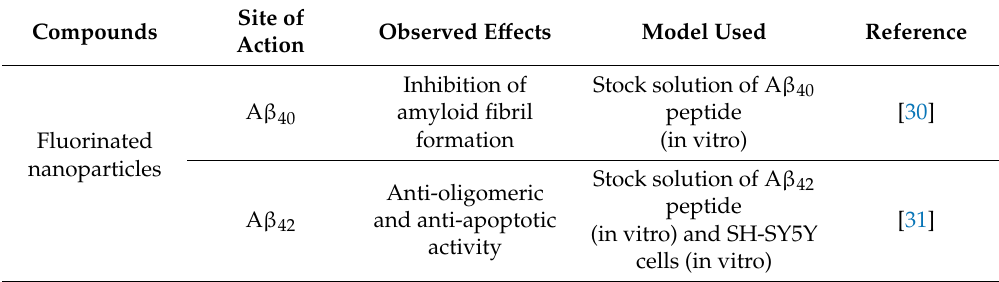
Table 3. Fluorinated nanoparticles used for the treatment for